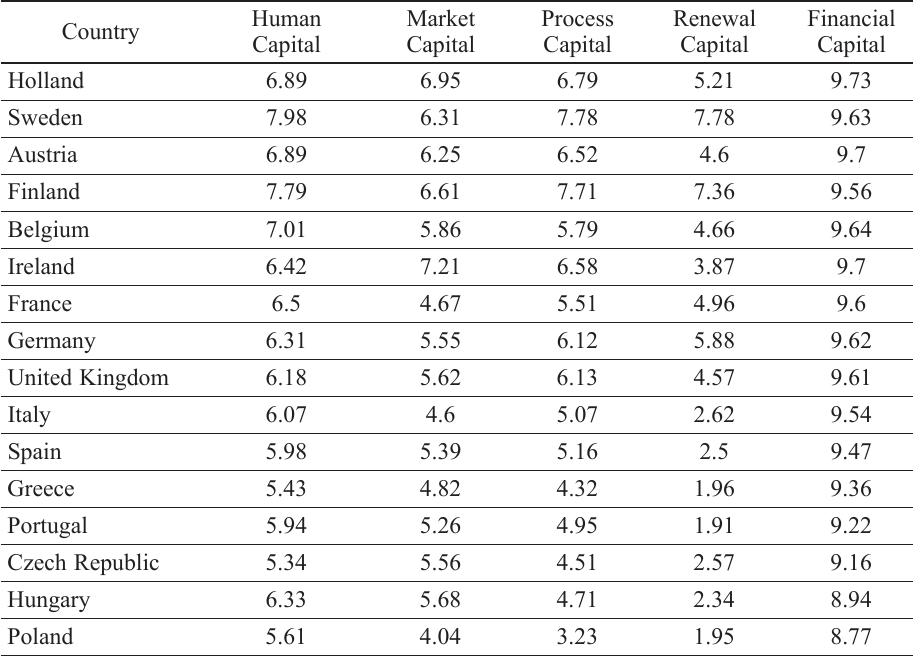
Table 3. Values of human, market, process, renewal and financial capital for particular countries Human Market Country Capital